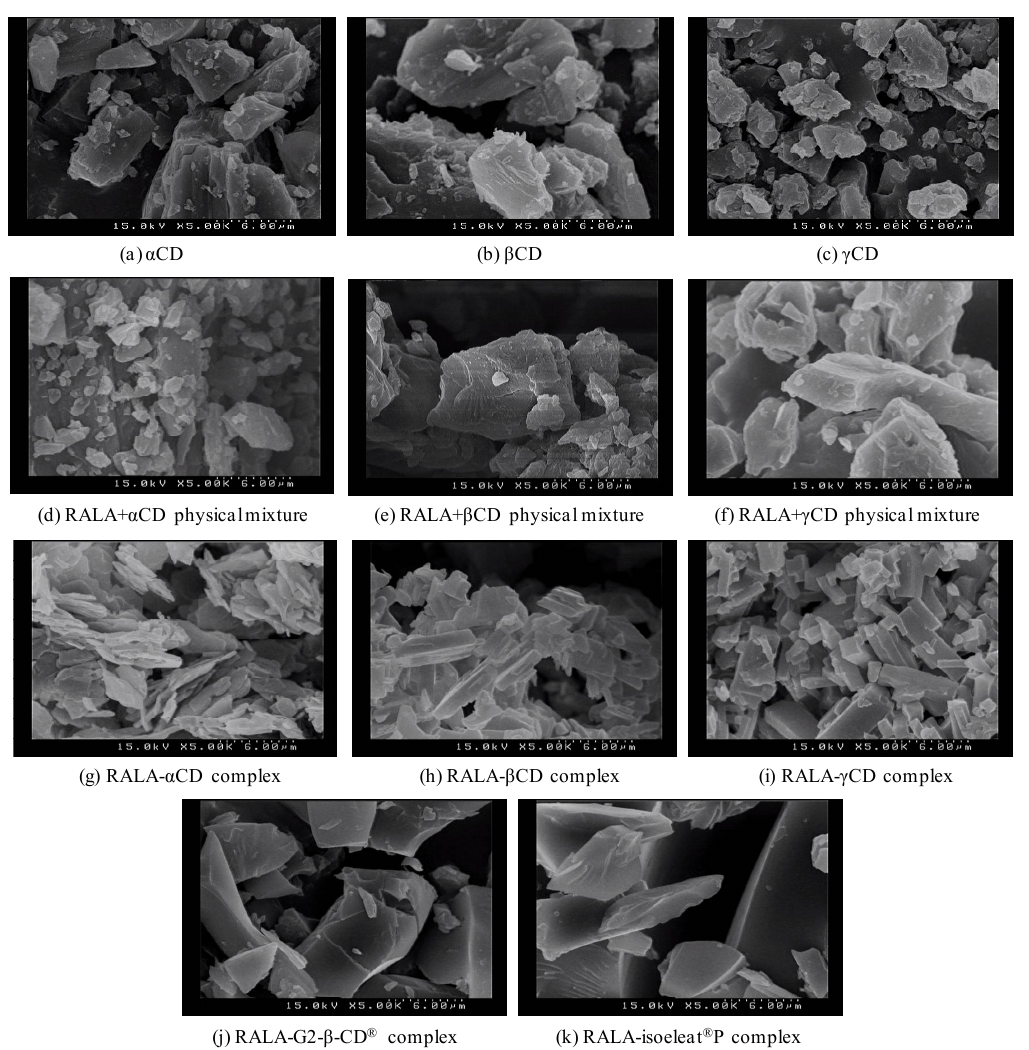
Figure 5. SEM images of CD, RALA + CD physical mixtures and RALA-CD